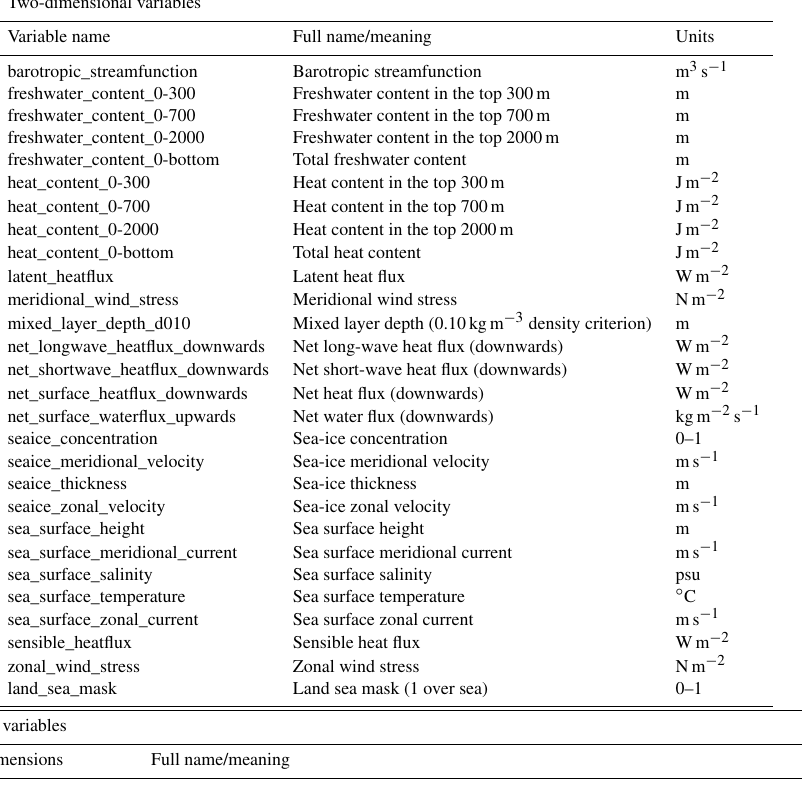
Table A1. C-GLORSv5 disseminated ocean and sea-ice